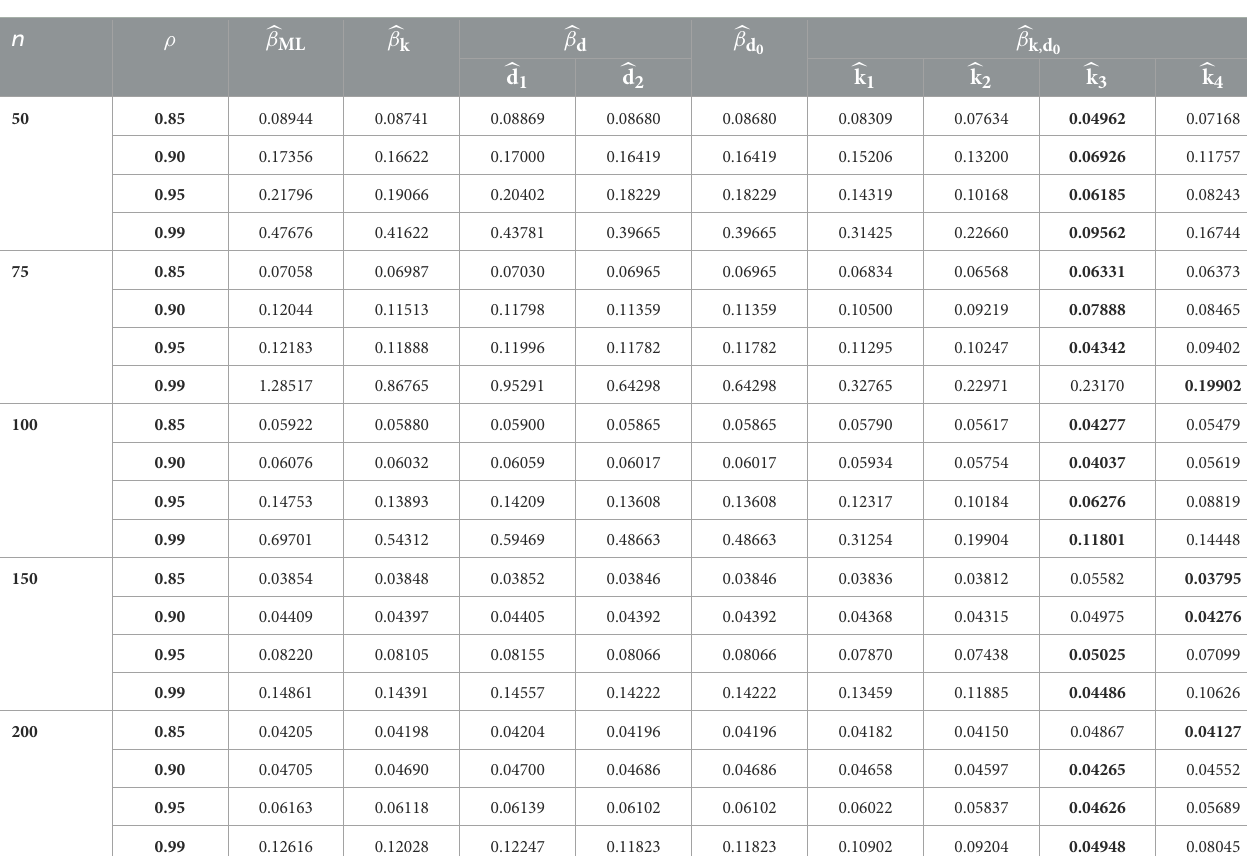
TABLE 4 MSE values in case of p = 6 and γ =